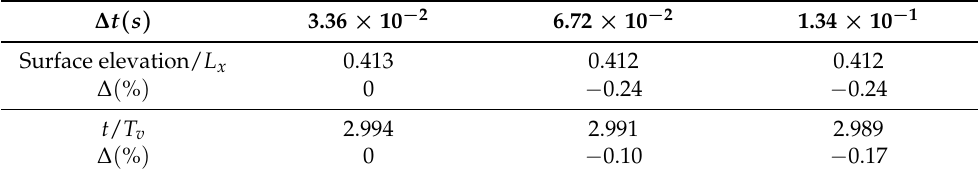
Table A12. Time step sensibility analysis for the nonlinear regime: maximum value of surface elevation/ L x , its time location t / T v , and their relative difference compared to ∆ t ( s ) = 3.36 × 10 − 2 s for FT S .